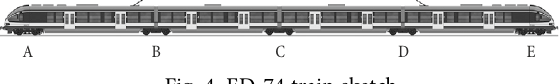
Set of accelerometers and temperature sensors